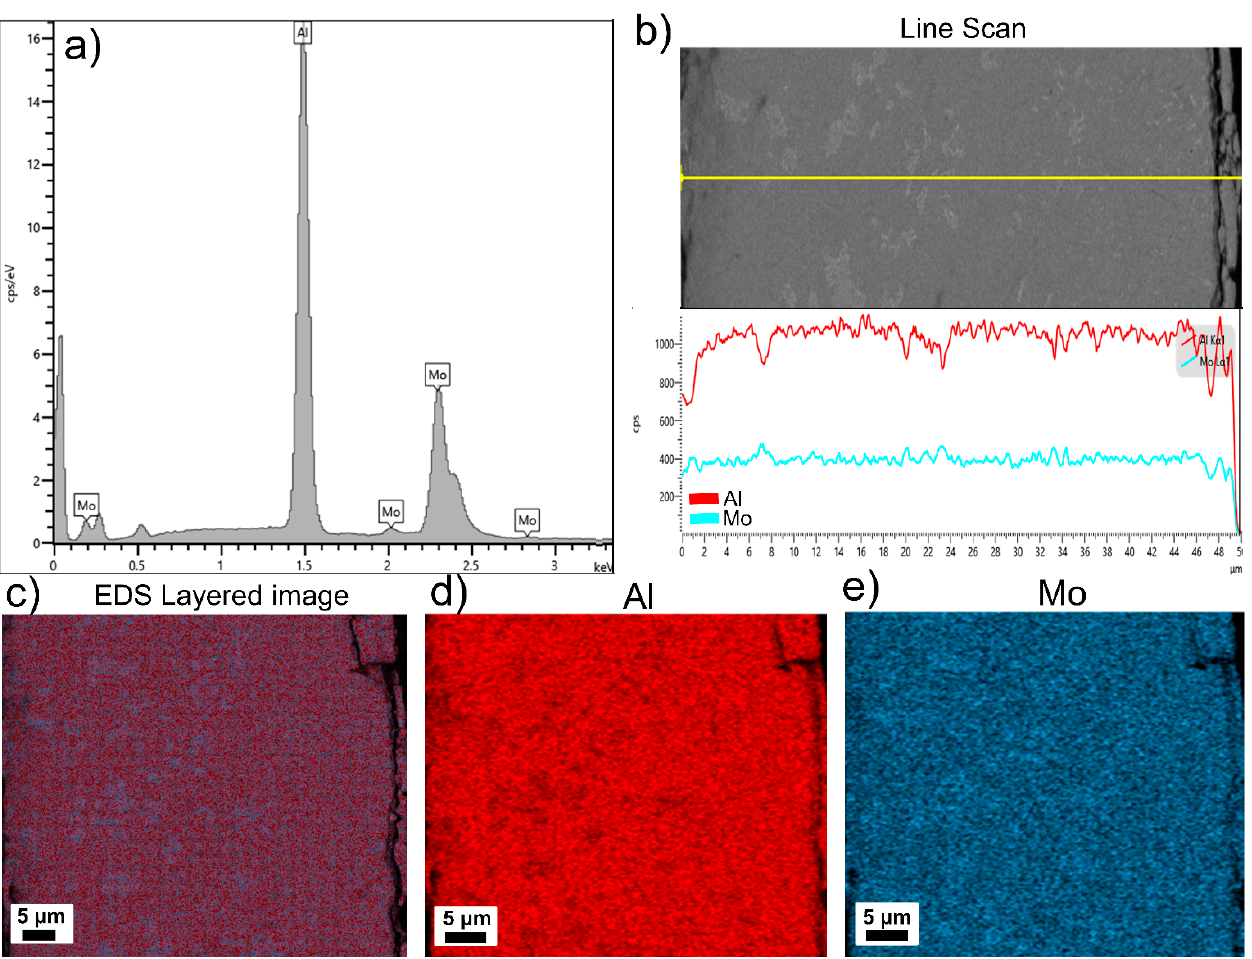
Figure 3. Energy-dispersive X-ray spectroscopy (EDS) analyses of the cross-section of the as-quenched ribbon: ( a ) EDS spectrum; ( b ) Line scan—red signal for Al and cyan signal for Mo; ( c ) Layered compositional map depicting Mo and Al content; ( d ) Map showing only Al content and; ( e ) Map showing only Mo content.